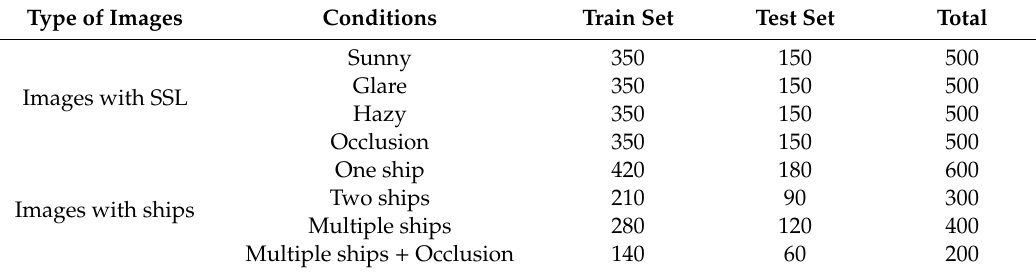
Table 3. Detailed information of the experiment